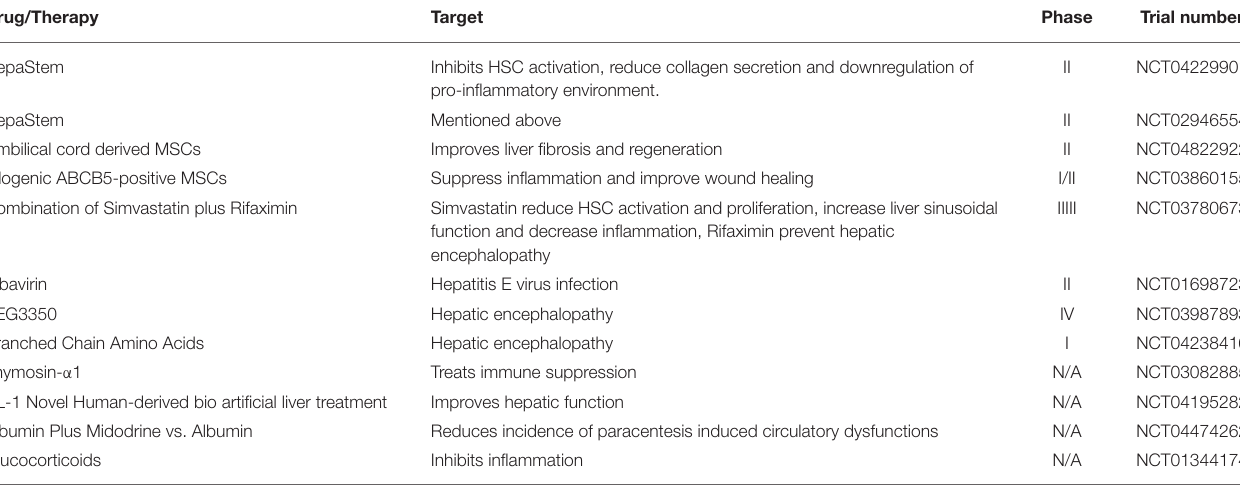
TABLE 1 | Clinical trials for the treatment of